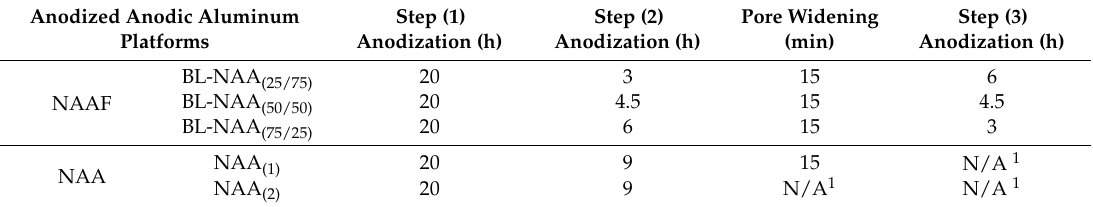
Figure 1. Fabrication process of interferometric bilayered nanoporous anodic alumina (BL-NAA) structures. ( a ) Electro polished high purity aluminum; ( b ) First step of anodization and resulting chemically etched nanostructure; ( c ) Second step of anodization results top layer of BL-NAAs; ( d ) Pore-widening leads to nanopores with a larger pore diameter; ( e ) Third step of anodization results in the bottom layer of the nanopore structure which has a smaller pore diameter compared to top layer; ( f ) Supporting aluminum was removed from the backside of platform. * Note that, stage ( e ) was not included for nanoporous anodic alumina (NAAs) fabrication. Table 1. Fabrication protocol of BL-NAAs and NAAs that combines anodization and pore widening steps (BL-NAA (25/75) represent ratio in lengths of pore layers with 25% top layer with larger pore diameters and 75% of layer with layer with smaller pore diameters, BL-NAA (50/50) with equal length of both layers and the BL-NAA (75/25) structure with 75% top layer with larger pore diameters and 25% of layer with layer with smaller pore diameters, and NAA (1) with uniform structures with large pore diameters and NAA (2) with smaller pore diameters.)